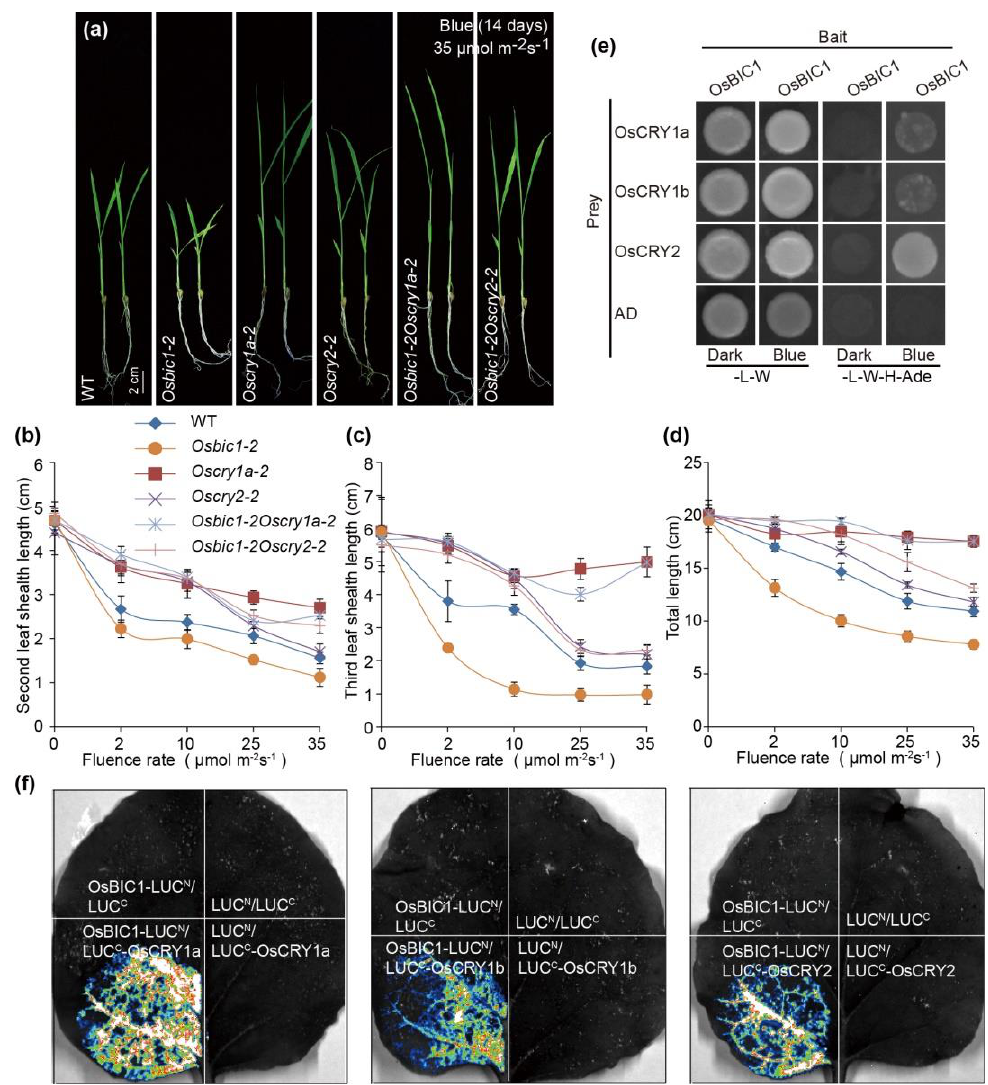
Figure 2. OsBIC1 directly interacted with OsCRYs (OsCRY1a, OsCRY1b, and OsCRY2) to control leaf sheath length under blue light conditions. ( a ) Representative seedlings image of WT and each indicated mutants grown under continuous 35 µmol m −2 s −1 blue light conditions at 28 °C for 14 days. Scale bars = 2 cm. ( b – d ) The statistics results of second leaf sheath length ( b ), third leaf sheath length ( c ), and total length ( d ) of 14 days old seedlings grown under continuous blue light with intensity of 0 to 35 µmol m −2 s −1 . Mean values ± s.d. ( n = 20) are shown. ( e ) OsBIC1 interacted with OsCRYs in yeast two-hybrid assays. Empty vector expressing the AD domain was negative control. ( f ) Interaction between OsBIC1 and OsCRYs under long day conditions in LCI